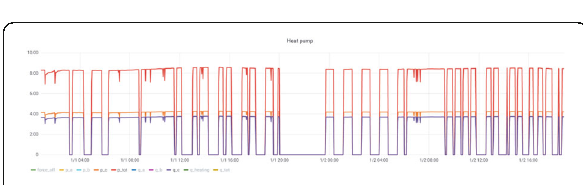
Fig. 3 (abstract P9). Simulation output for a heat pump